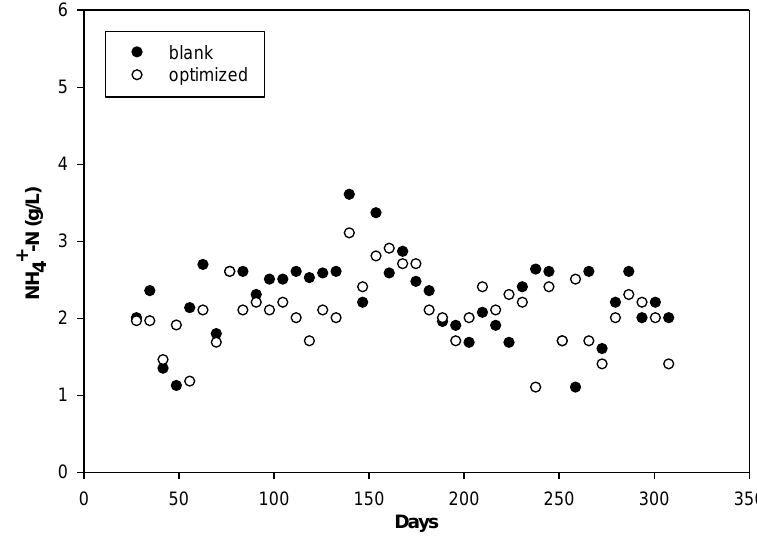
Figure 5. Concentration of ammonium nitrogen in effluent of both digesters over time.